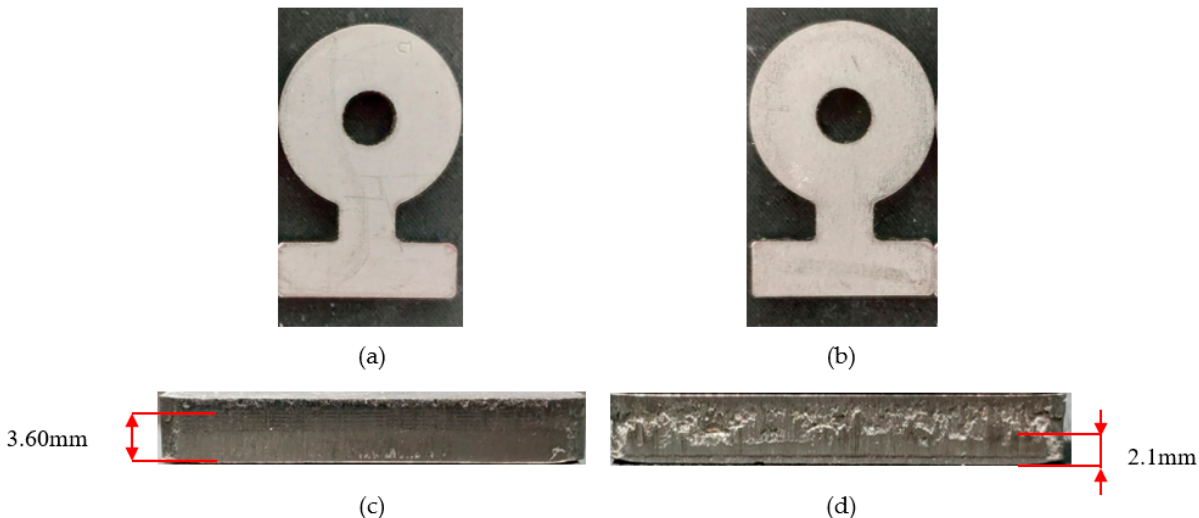
Figure 16. Comparison between the process of constant average force load and force variation load; ( a ) top surface of parts produced by force variation load applied; ( b ) top surface of parts produced by average force constant load applied; ( c ) fracture surface of parts produced by force variation load applied; ( d ) fracture surface of parts produced by average force constant load applied.